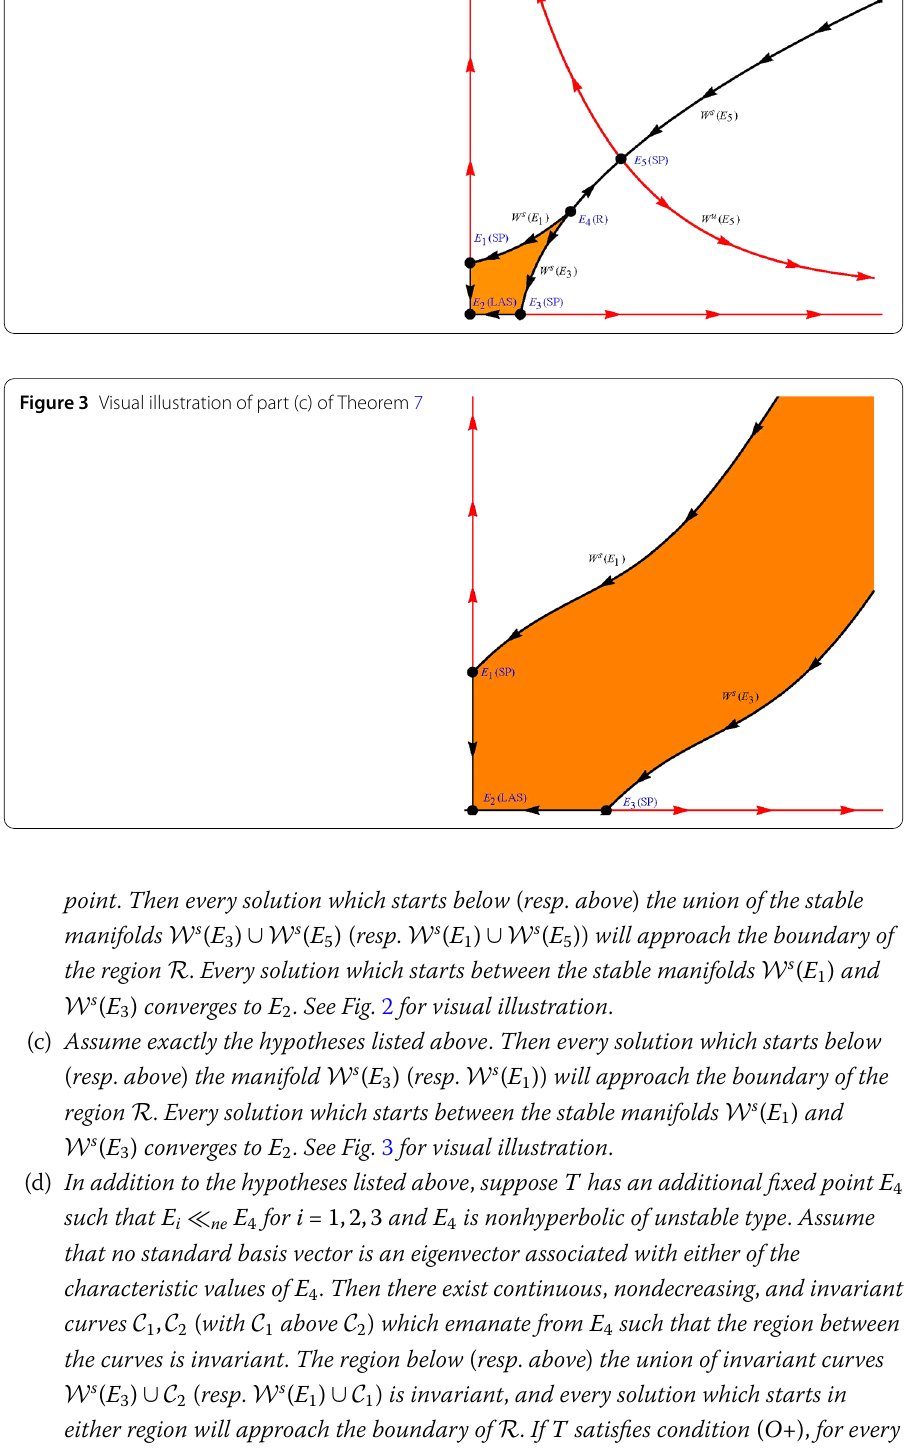
Figure 3 Visual illustration of part (c) of Theorem